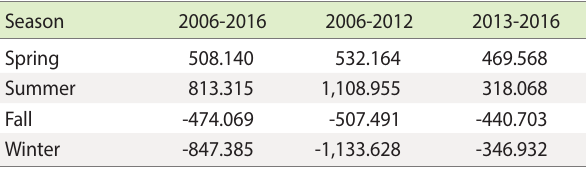
Table 4. Seasonal indices by seasonal decomposition method